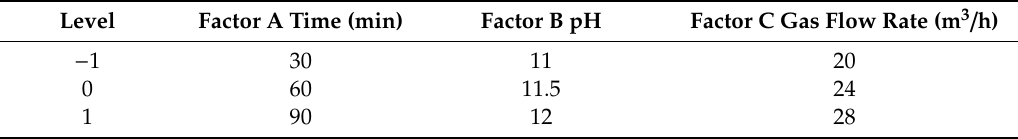
Table 2. Factors and levels of response surface experiment.